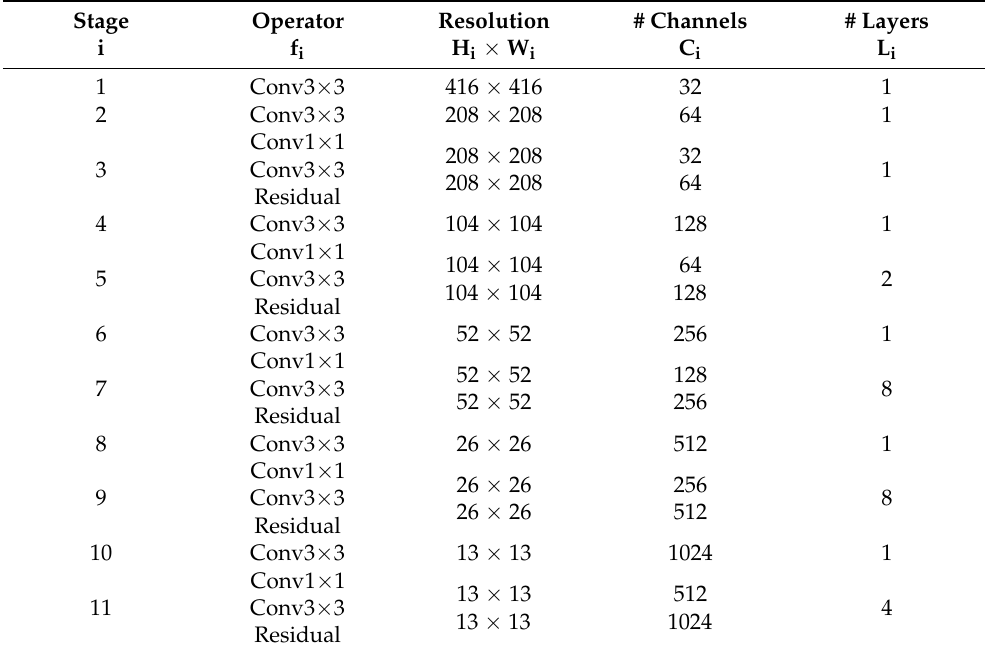
Table 2. Darknet-53 feature extraction network